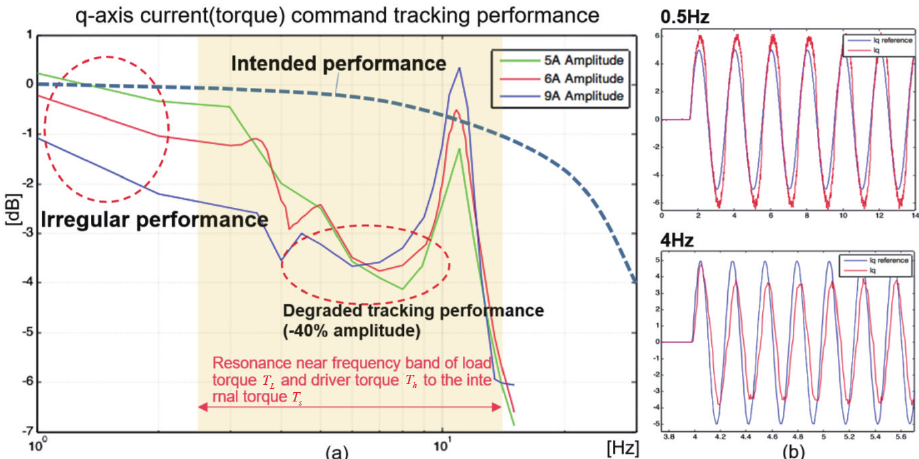
Figure 3. The performance degradation of the linearized feedback PI controller widely used in industry (a test on a commercial motor controller of an EPS system): ( a ) torque tracking performance degradation; ( b ) individual frequency tracking performances